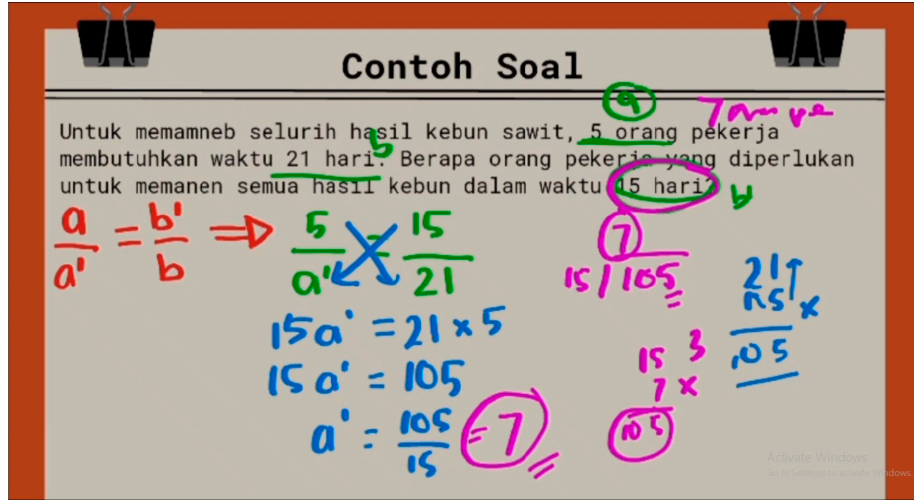
Figure 2. Explanation of type inverse topic exercises on micro-lectures.